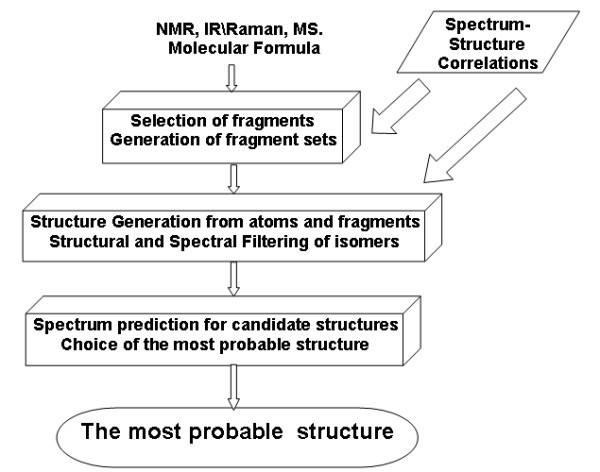
Flow diagram of a CASE system.